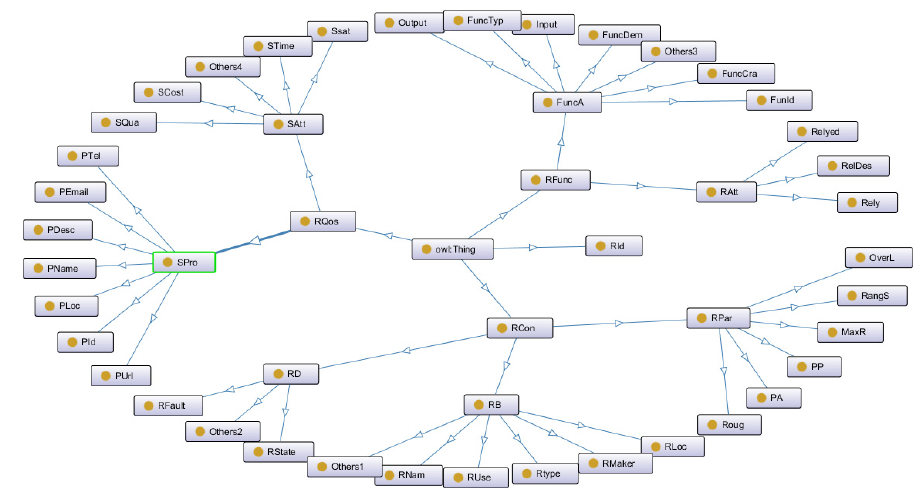
Figure 3. The ontological diagram of the descriptive model.